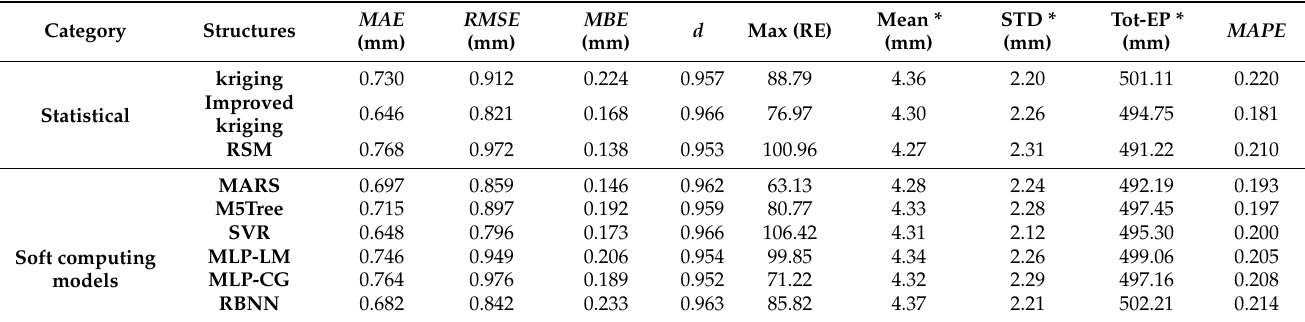
Table 2. Comparing the results of the applied models with periodicity (Scenario #2) for Adana station in the testing period. Category